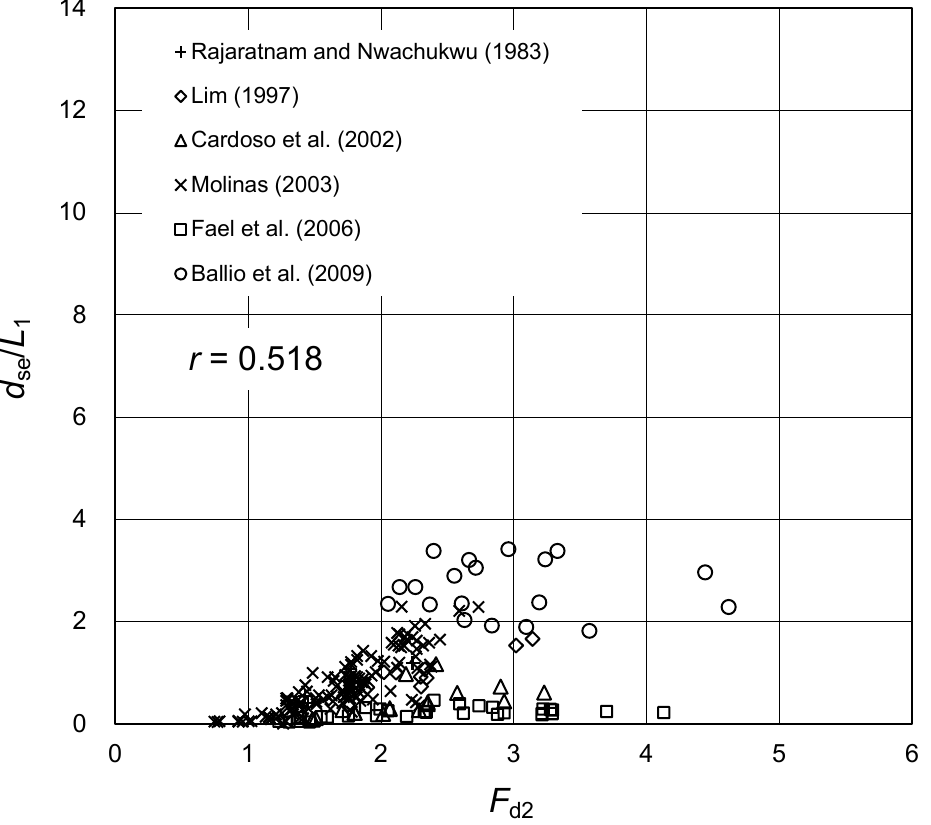
Figure 3. Plot of d se / L 1 against F d 2 ( L 1 = b Figure 3. Plot of (cid:1856)